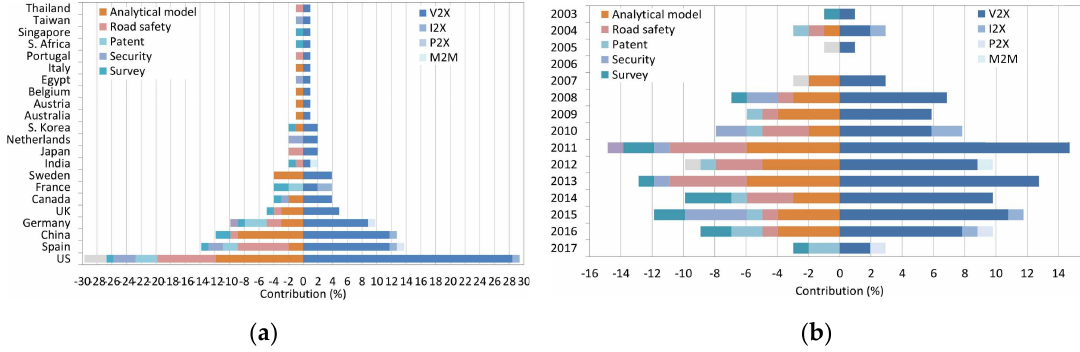
Figure 3. For a representative sample of the 100 most cited publications in the state-of-the-art: ( a ) Type of communication and use case versus country, and ( b ) type of communication and use case versus year.